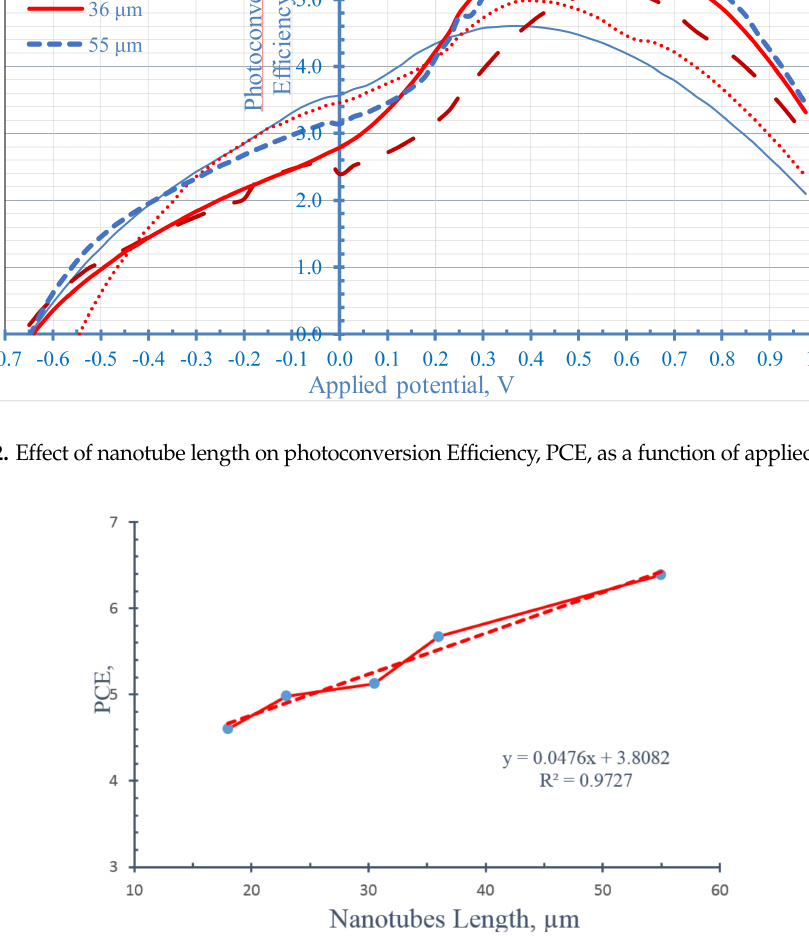
Figure 13. Linear dependence of photoconversion efficiency on nanotube length of modified TNTAs in the range from 18 to 55 µ m. The solid line represents the actual experimental data and the dotted line represents the best-fitting straight line through the data which is defined by the equation shown in the